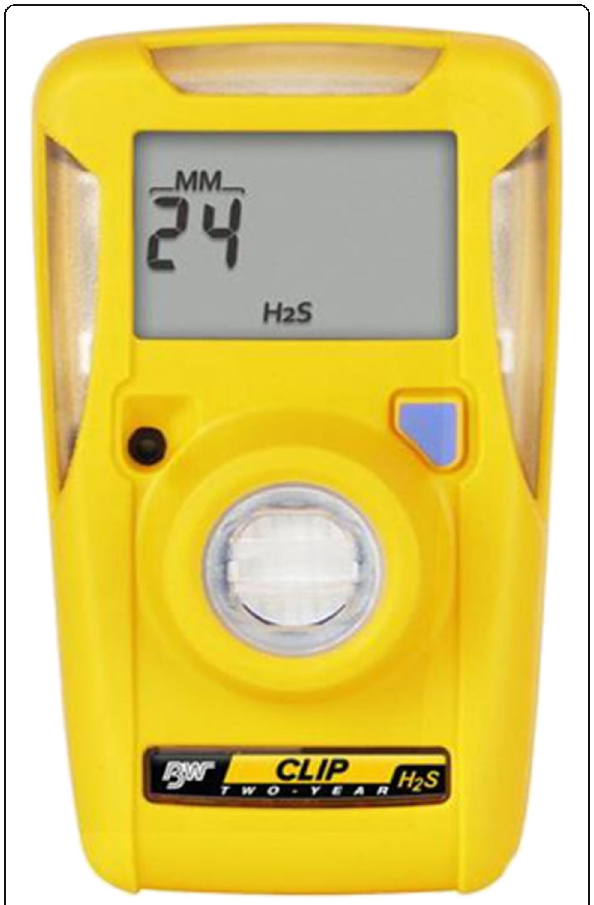
Fig. 1 Example of a handheld environmental carbon monoxide